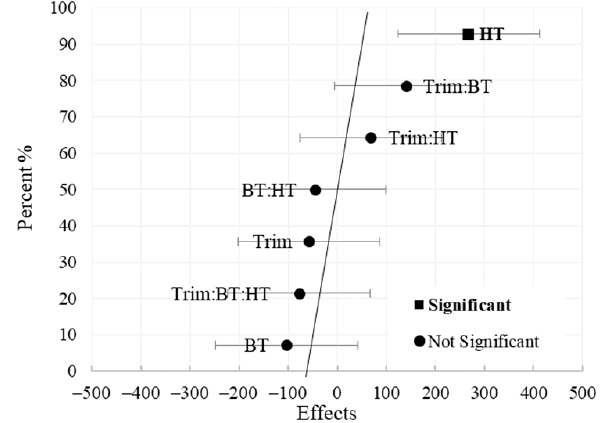
Figure 2. Normal probability of effect estimates at significance level of α = 0.05 for the G* ( ω = 10 rad/s) at 60 °C for 50/70.